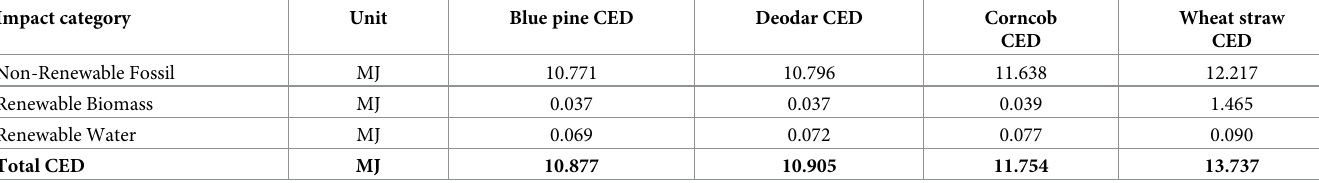
Table 4. Cumulative energy demand of biomass pellets from different agroforestry species residues. Impact